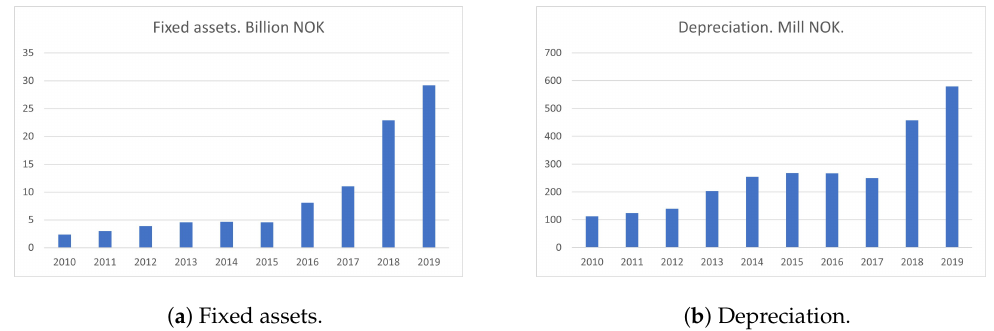
Figure 13. Book values of fixed assets to all wind power producers in Norway and the depreciation. Period of 2010–2019.